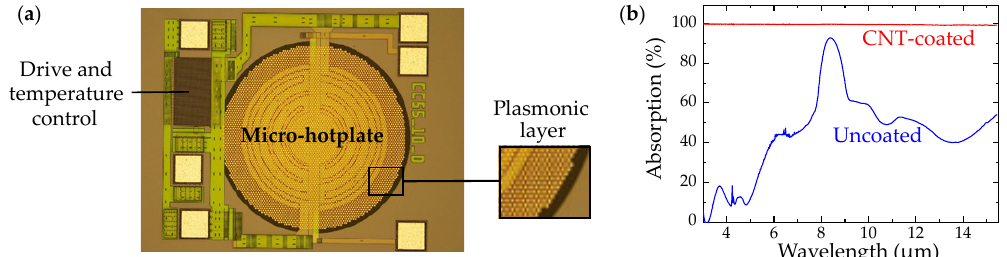
Figure 4. ( a ) Complementary metal-oxide semiconductor (CMOS) integrated plasmonic microhotplate with drive and temperature control. ( b ) Mid-infrared spectra of carbon nanotubes (CNT)-coated and uncoated devices